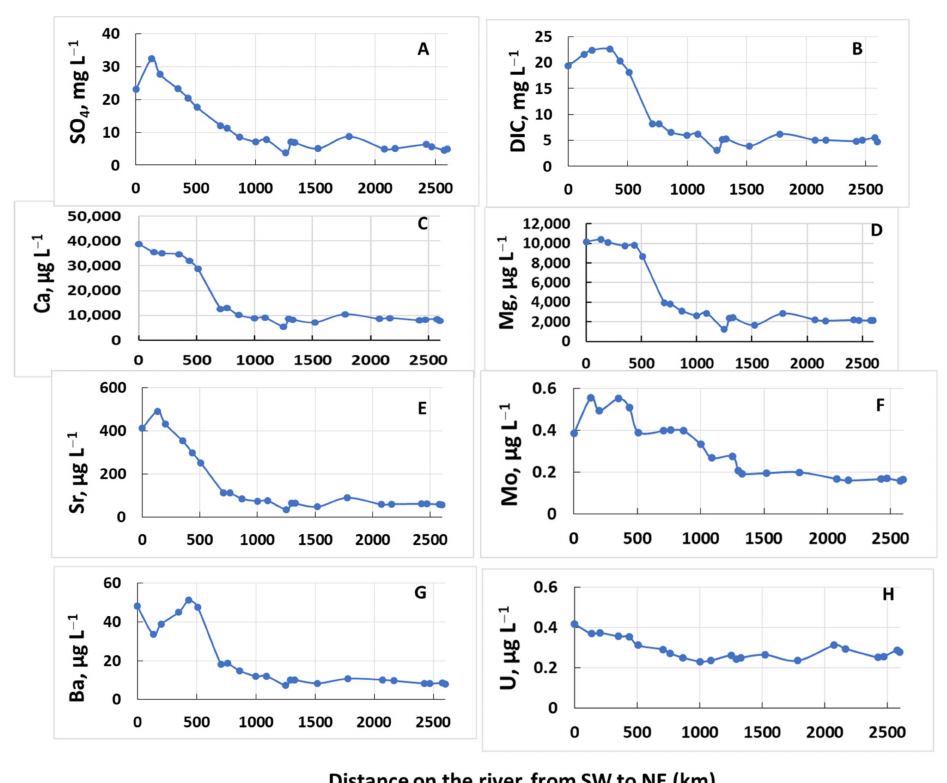
Figure 2. Examples of elements decreasing their concentration in the main stem of the Lena River from SW to NE: SO 4 ( A ), DIC ( B ), Mg ( C ), Ca ( D ), Sr ( E ), Mo ( F ) Ba ( G ) and U ( H ) The distance is km of river from Zhigalovo (0 km, upper reaches) to the Aldan River (~2600